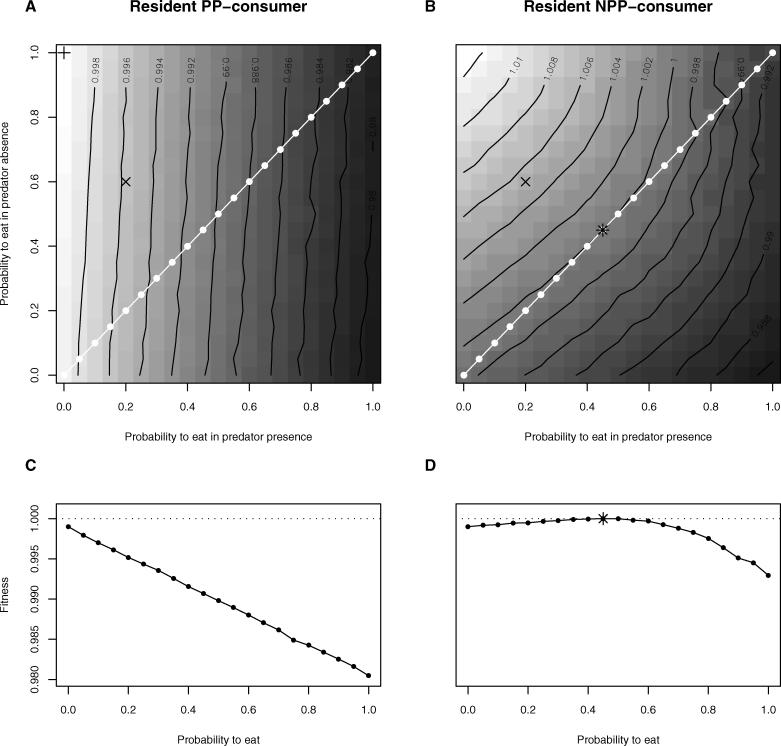
Fitness SurfacesFitness surfaces for a focal consumer in the presence of either an optimal resident PP-consumer (A) or an optimal resident NPP-consumer (B). Each surface shows fitness as a function of the focal consumer foraging strategy, i.e., of the two traits that describe the probability of eating in predator presence and absence, respectively. Fitness is measured (Methods) in a habitat in which resource levels and dynamics have reached a steady state of the resident species. In (A) the resident PP-consumer has a probability of eating in predator presence and absence of 0.0 and 1.0, respectively (indicated by the plus sign [+]), which is the optimal value for a PP-consumer when alone. In (B) the resident NPP-consumer has a probability of eating of 0.45 in predator presence and absence (indicated by the asterisk [*]), which is the optimal strategy for an NPP-consumer when evolved alone. The fitness of a focal consumer, relative to the respective optimal individual in each figure, is given for each combination of eat probability traits (i.e., in predator presence and absence), where the isopleths in (A) and (B) represent fitness relative to the optimal strategies in the respective cases. For example, an individual with a 0.20 probability of eating in predator presence and 0.60 probability of eating in predator absence (indicated by the x ), had a fitness value of 0.996 with a resident PP-consumer (A) and 1.006 in a habitat with a resident NPP-consumer (B). Because NPP-consumers cannot respond differentially to predation risk, they are restricted to the diagonal (white) lines in (A) and (B), so that the probabilities of eating in predator presence and absence are always equal. Therefore NPP-consumers, when alone, will evolve to the highest point on that line as indicated in (B) by the asterisk (*). Figures (C) and (D) show fitness of the focal consumer as a function of probability to eat when that probability is the same in both predator presence and absence (i.e., along the diagonal in [A] and [B]), in habitats with resident PP-consumers (C) and NPP-consumers (D), respectively.